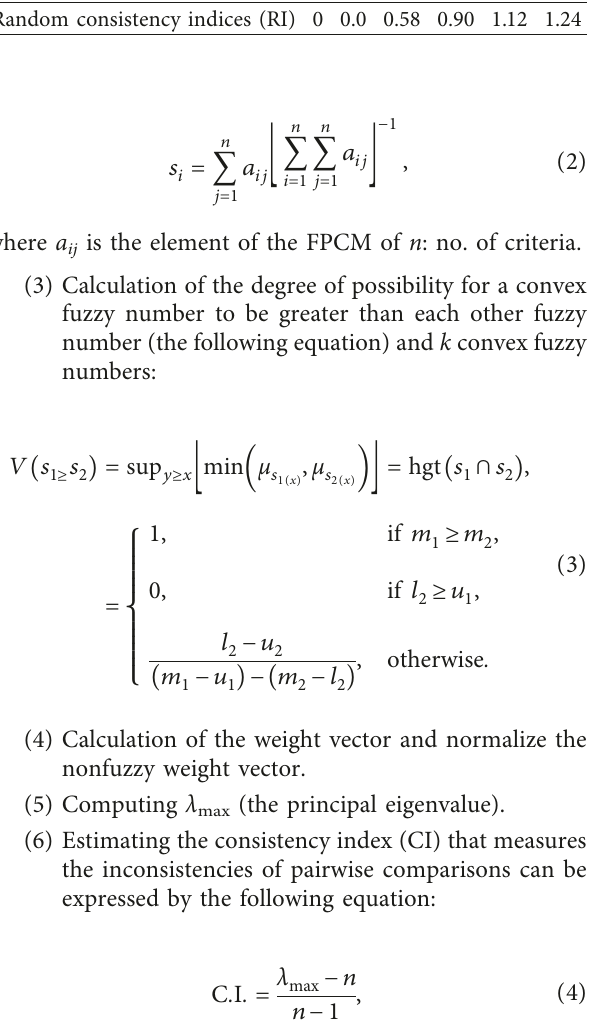
Table 2: Average random consistency indices (RI) for different number of criteria (adapted from [32]). Number of criteria ( N